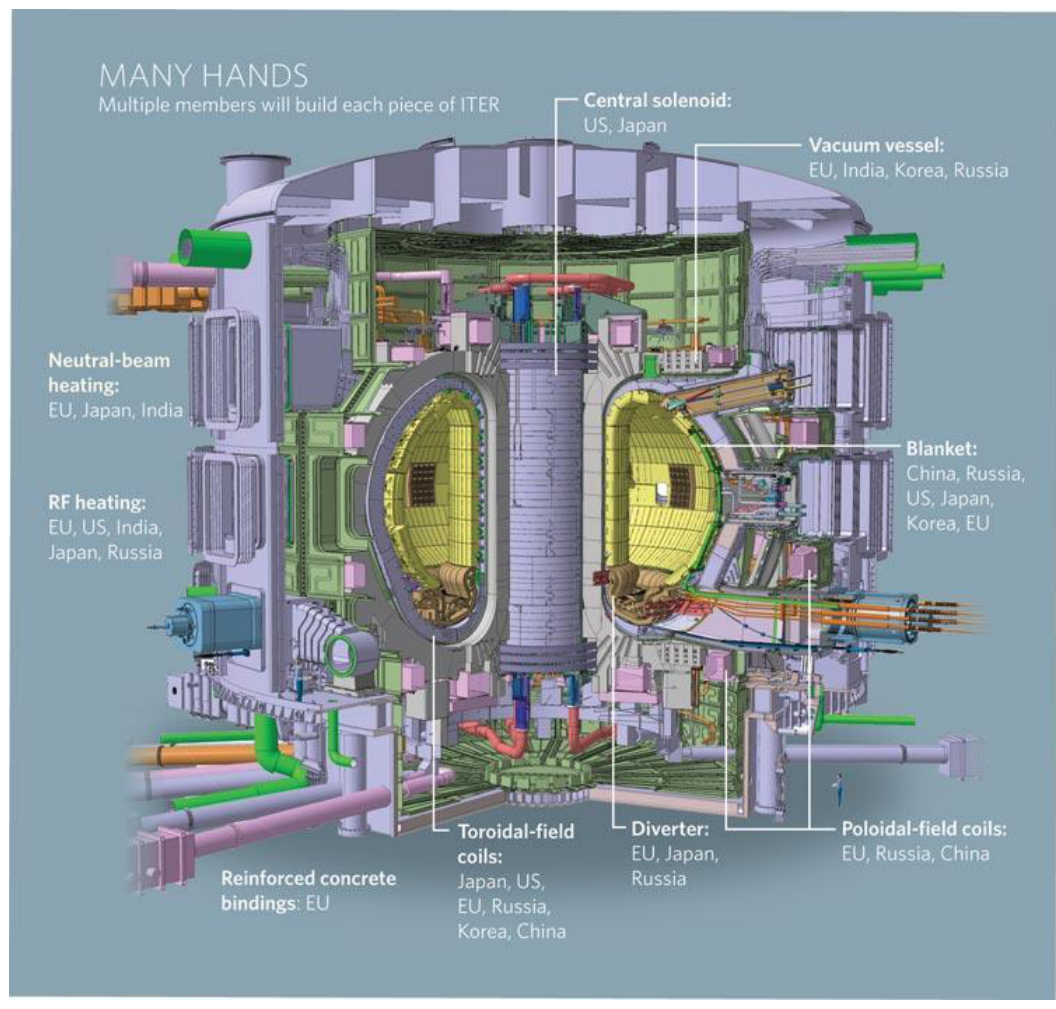
Figure 1. ITER scheme. This figure is taken from [4].